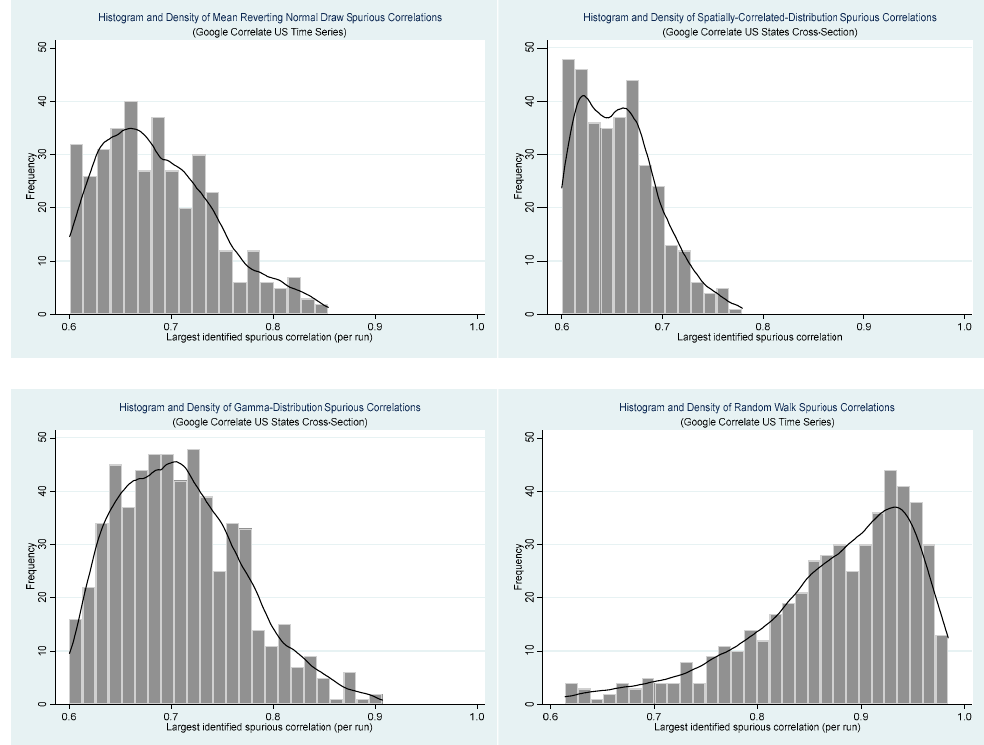
Figure 4. Density of maximum spurious correlations: gamma (1, 1), spatially correlated, Gaussian random walk, and mean-reverting normal distributions. Note: each distribution is censored at r = 0.60, which excludes some experiments from the figure (see Table 3 for the portion of experimental runs that were censored).